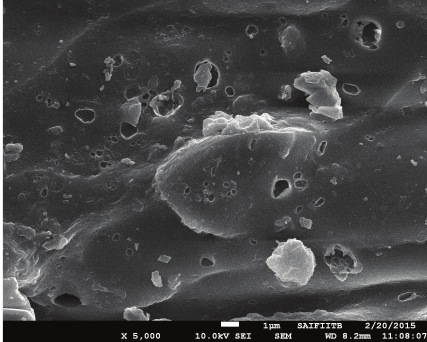
Figure 4: SEM image of lead ion loaded CRSD.